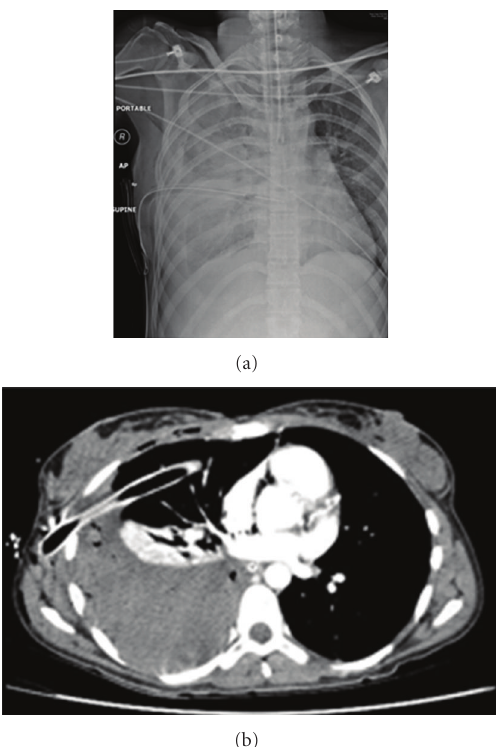
Figure 21: A CXR and axial CT show an inappropriately placed chest drain in an attempt to drain a right basal pleural e ff